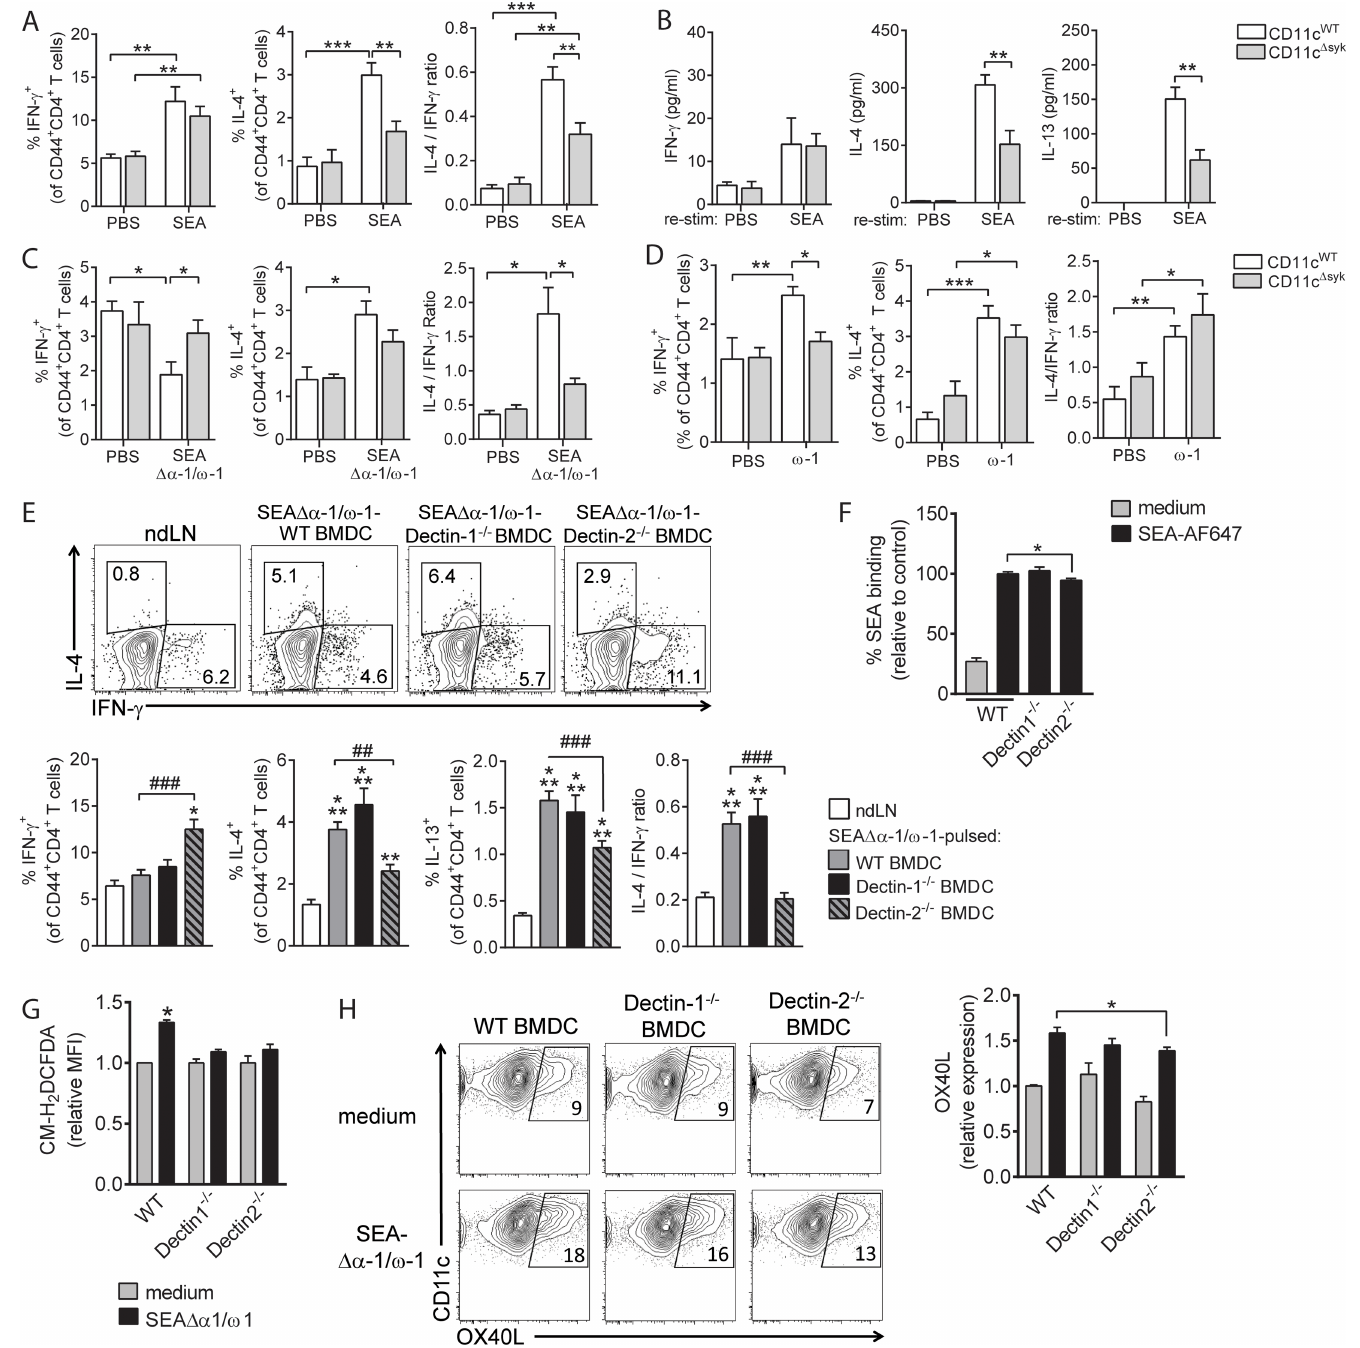
Fig 6. Th2 polarization induced by SEA is mediated via Dectin-2 and Syk signaling in vivo. (A–D) WT or CD11c Δ Syk mice were injected with SEA (panel A, B), SEA Δα -1/ω-1 (panel C), or ω-1 (panel D) in the hind footpad, and draining pLNs were analyzed 7 d later. (A, C, D) pLN cells were restimulated with PMA/Ionomycin in the presence of brefeldin A, and CD4 + T cells were stained for indicated intracellular cytokines and percentage cytokine-positive CD4 + T cells enumerated. Based on these data, the ratio between the percentage IL-4 + over IFN- γ + CD4 + T cells was determined as a measure for overall skewing towards Th2. (B) pLN cells were restimulated with SEA for 72 h, and cytokine levels in culture supernatants were determined. (A–D) Bar graphs represent mean ± SEM of 5 to 6 mice per group and are representative of 2 (panel A–C) or 1 (panel D) experiment. (E) BMDCs cultured from BM from WT, Dectin-1 − / − , or Dectin-2 − / − mice were pulsed overnight with SEA Δα -1/ω-1 and injected into hind footpads after which CD4 + T-cell responses were analyzed as in panel A. Representative flow cytometry plots of intracellular staining of CD4 + T cells are depicted, of which the data are enumerated in bar graphs representing mean ± SEM of 2 independent experiments with 3 to 6 mice per group. (F) SEA binding and uptake was determined as in Fig 4F. (G) ROS production by indicated BMDCs was determined as described in Fig 5E, 1 h after stimulation